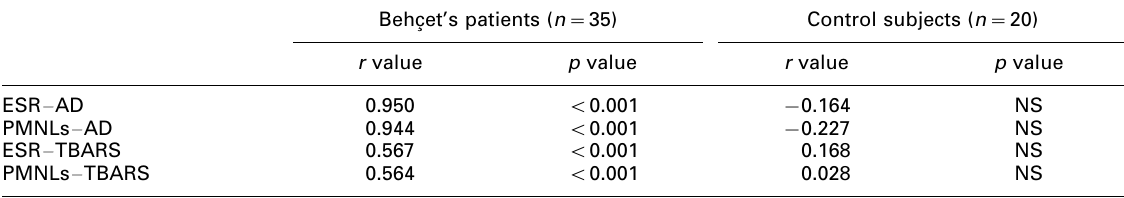
Table 5. Correlations between erythrocyte sedimentation rate and polymorphonuclear leukocyte count with adenosine deaminase and thiobarbituric acid-reactive substances in patients with Behc¸et’s disease